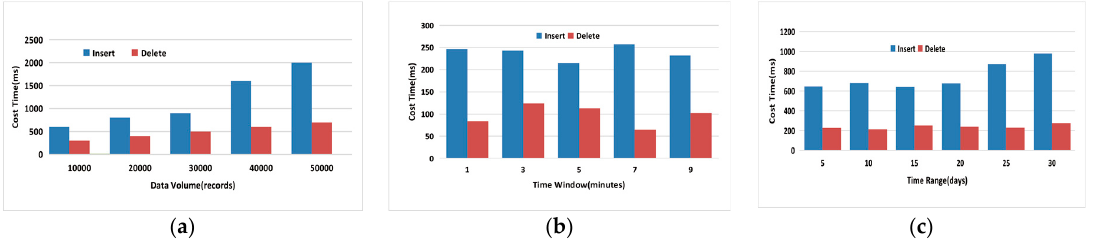
Figure 9. Comparison study for Updating: ( a ) Varying Data Volume; ( b ) Varying Time Window; ( c ) Varying Time Range.